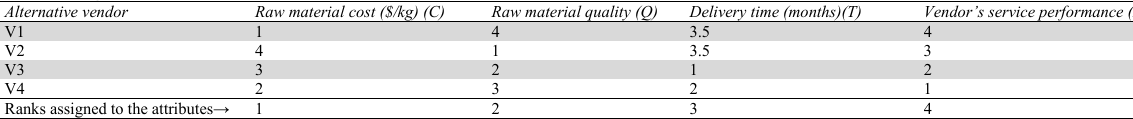
Ranks assigned to the alternatives and attributes Alternative